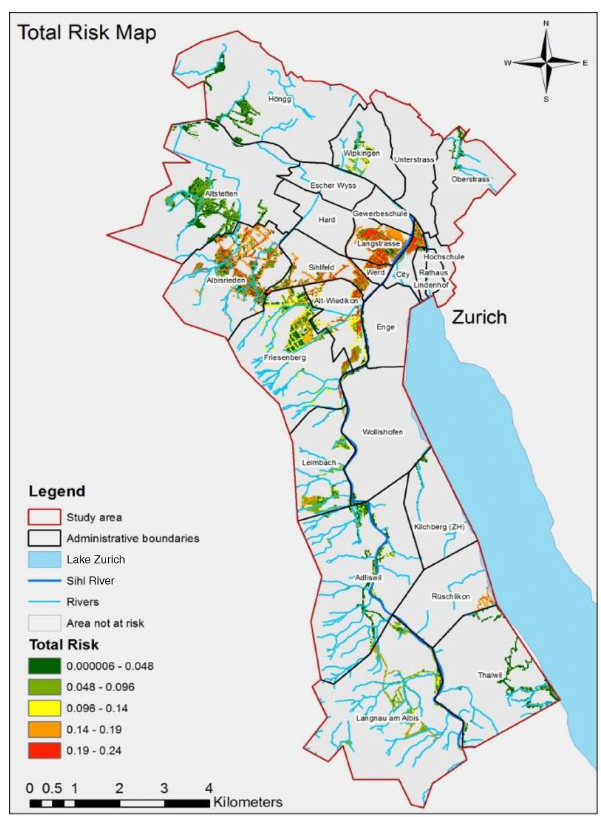
Figure 12. Total risk map for the Sihl River valley considering the 300-year return period